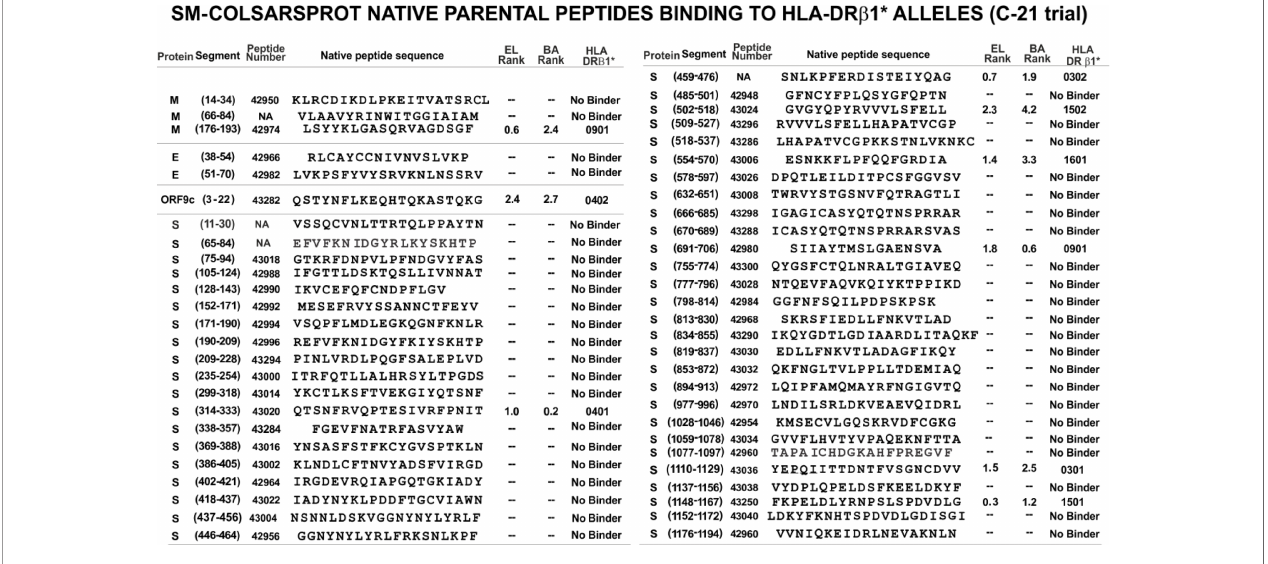
FIGURE 4 | Native selected peptides, based on their structural and functional characteristics. The aa sequences reported for B.1/D614G strain were analysed for their elution (EL) to HLA-DR b 1* puri fi ed molecules and homozygous cell binding activity (BA): NetMHCIIpan-4.1 server-predicted peptide b inding: <2.5 percentile (i.e., threshold level) and core probability close to 1.0. They did not bind, even at >10 percentile